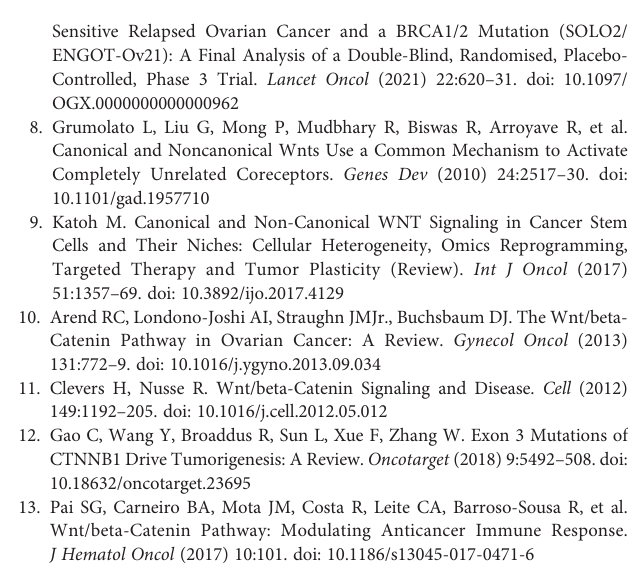
Supplementary Table S1 | Clinical information of patient samples used for IHC and organoid study. Supplementary Table S2 | Histologic subtypes of cell lines. Supplementary Table S3 | The IC50 to CWP232291 of cell